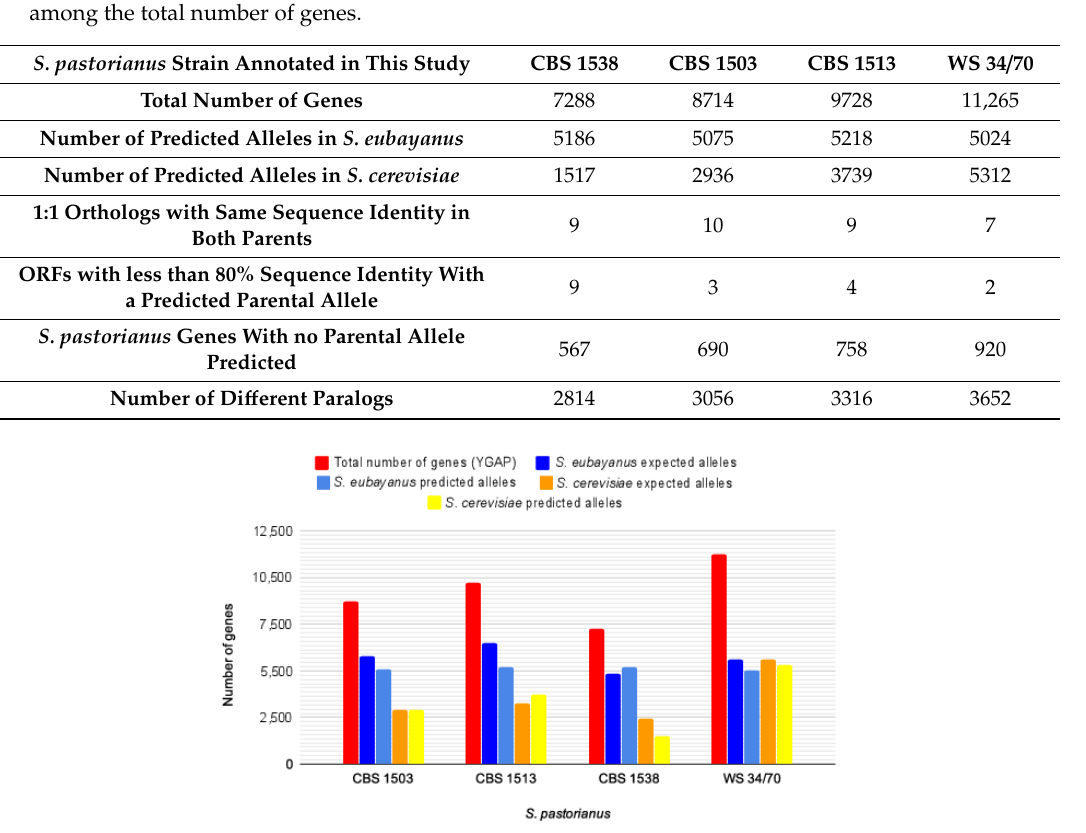
Figure 6. Histogram showing the amount of predicted versus expected S. cerevisiae -like and S. eubayanus -like genome content present in S. pastorianus strains CBS 1503, CBS 1513, CBS 1538, and WS 34/70.